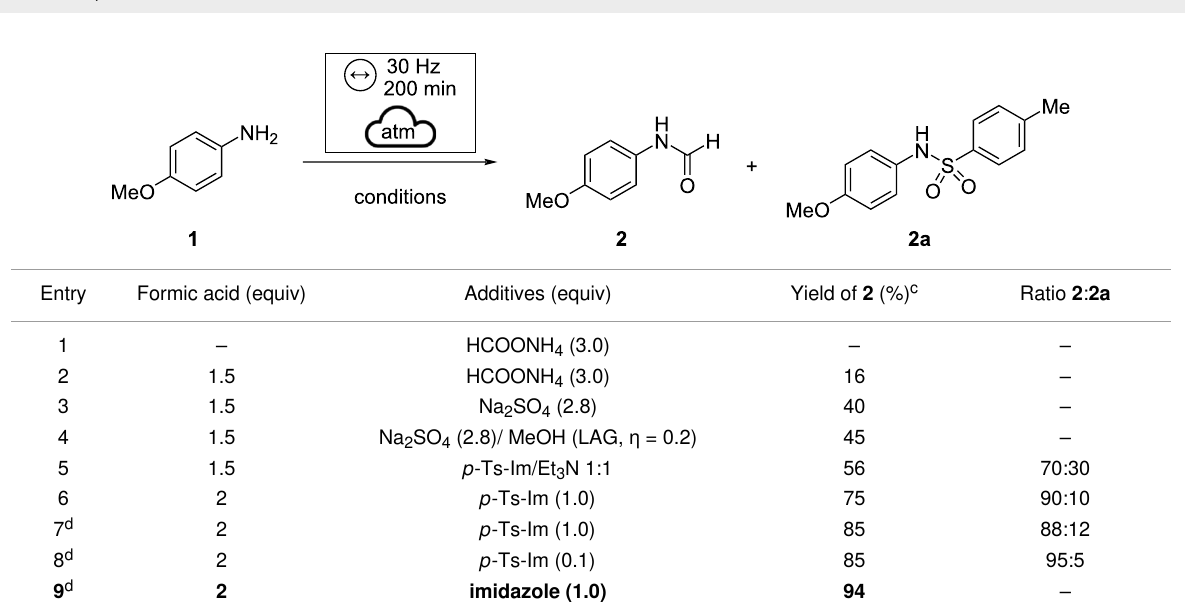
Table 1: Optimization of reaction conditions for 2 . a,b